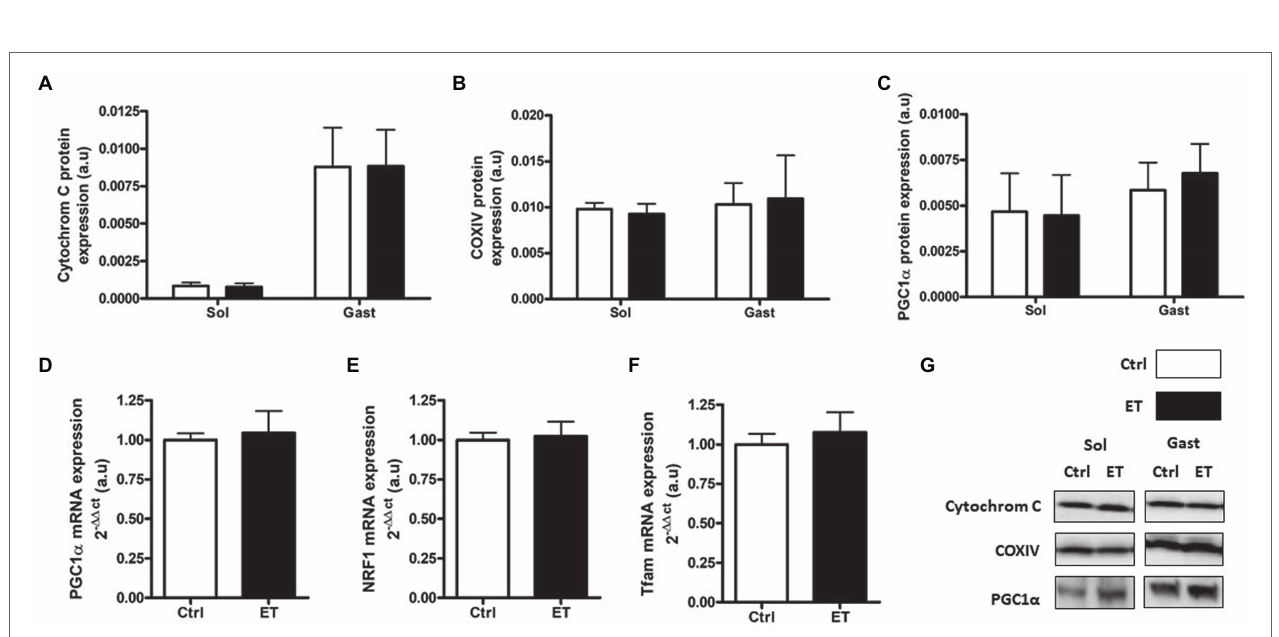
FIGURE 10 | Ergothioneine effect on antioxidant defense markers 2 h after exercise. Antioxidant defense markers in soleus and gastrocnemius samples. (A) SOD1 protein expression. (B) SOD2 protein expression. (C) SOD1 mRNA level. (D) SOD2 mRNA level. (E) Gpx1 mRNA level. (F) Nrf2 mRNA level. (G) Representative Western Blots; * p < 0.05 vs. Ctrl.